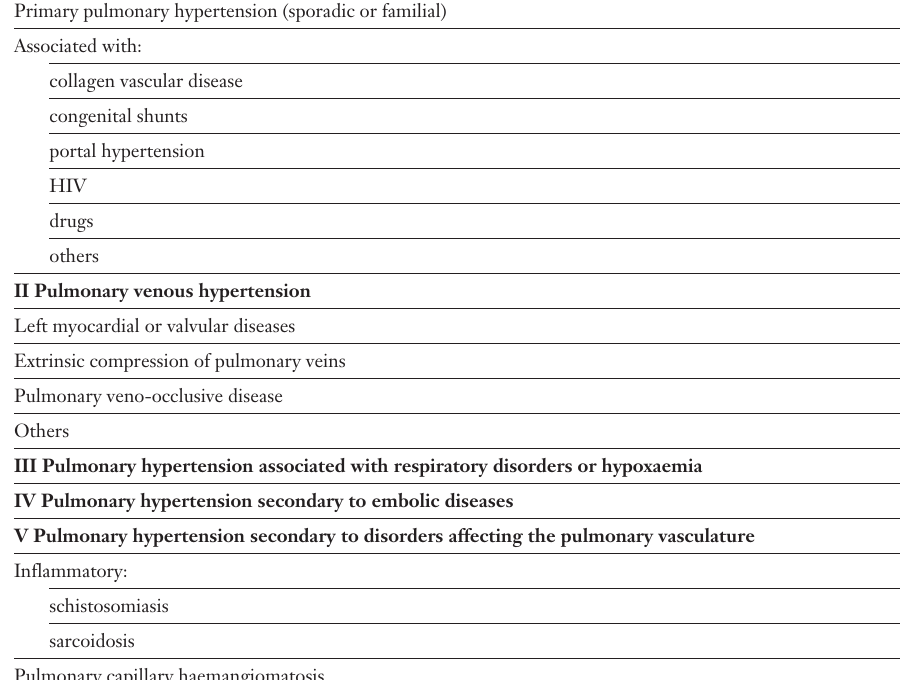
Classification of pulmonary hyper- tensive diseases (adapted from WHO, Evian